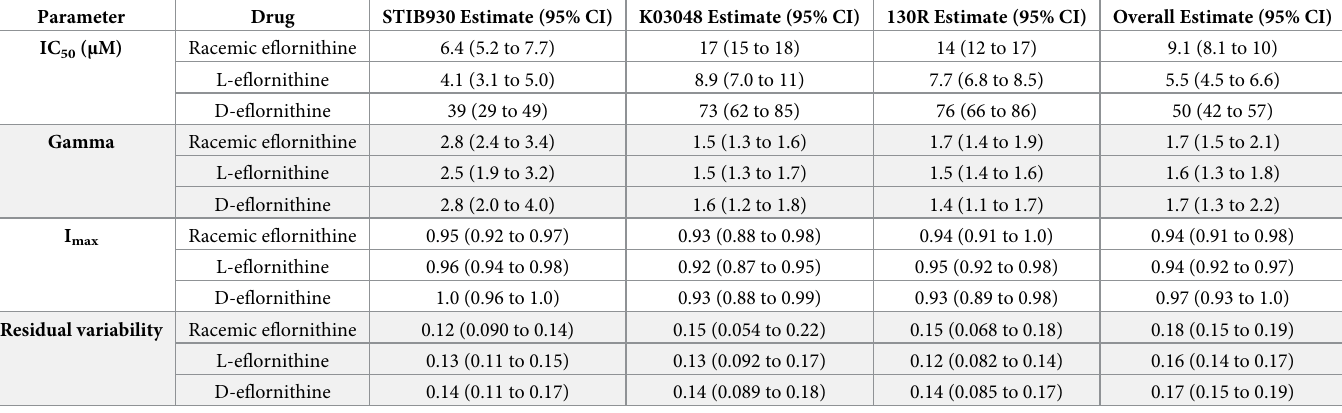
Table 1. IC 50 , gamma and I max estimates for racemic eflornithine, L-eflornithine and D-eflornithine in three different T . b . gambiense strains and overall across all strains.